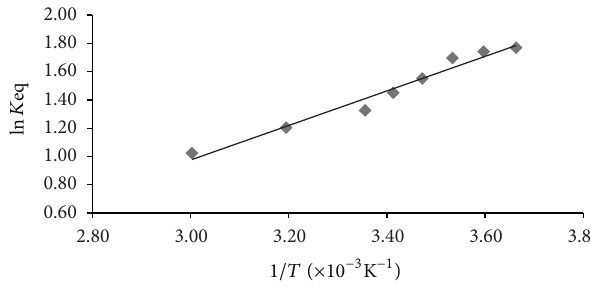
Figure 7: Representative van’t Hoff plot in D 2 O/ACND 3 (9/1).